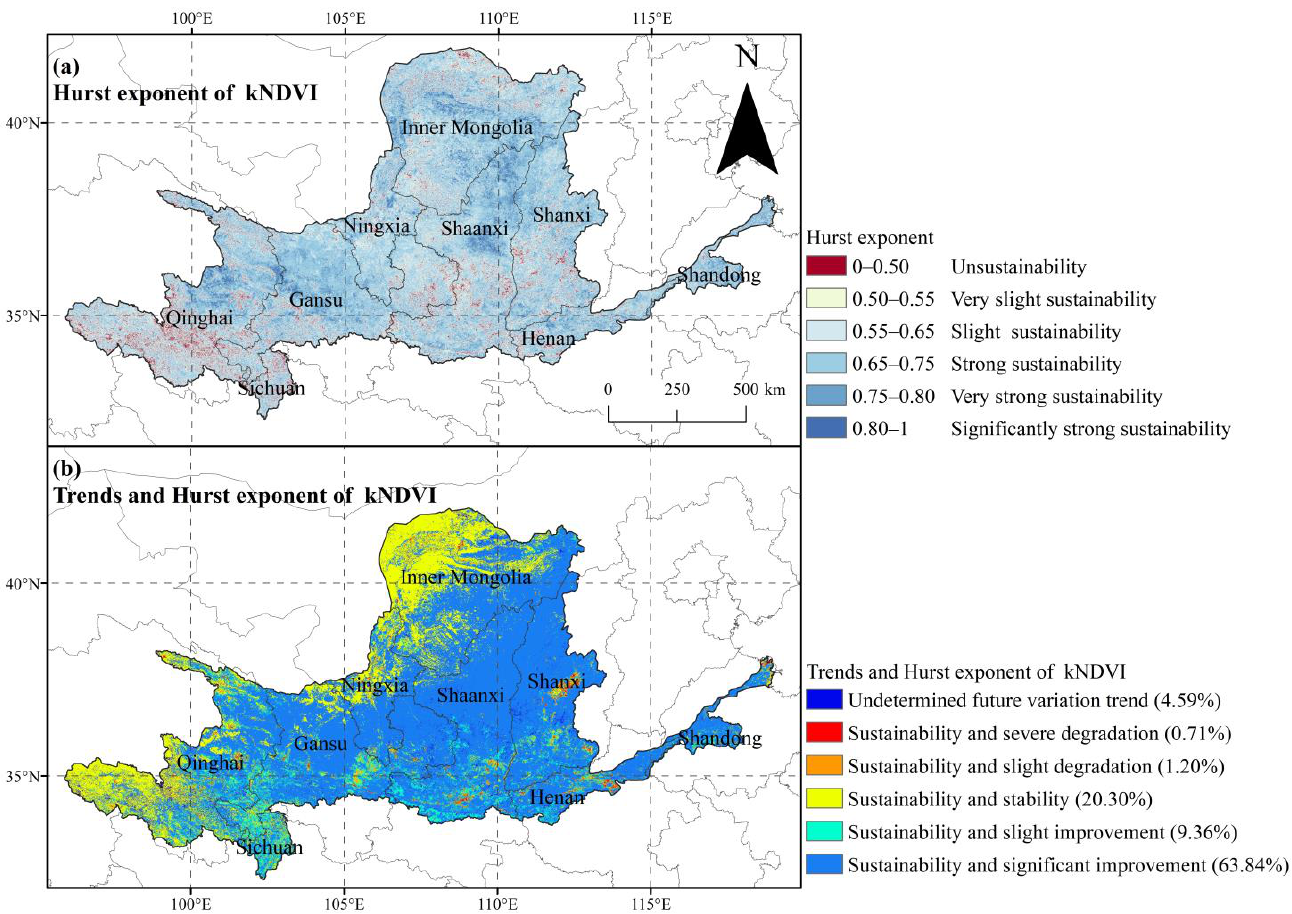
Figure 6. Spatial distribution of Hurst exponent and future trends in vegetation coverage: ( a ) spatial distribution of Hurst exponent and ( b ) spatial distribution of the kNDVI future development trends based on kNDVI trends and sustainability.